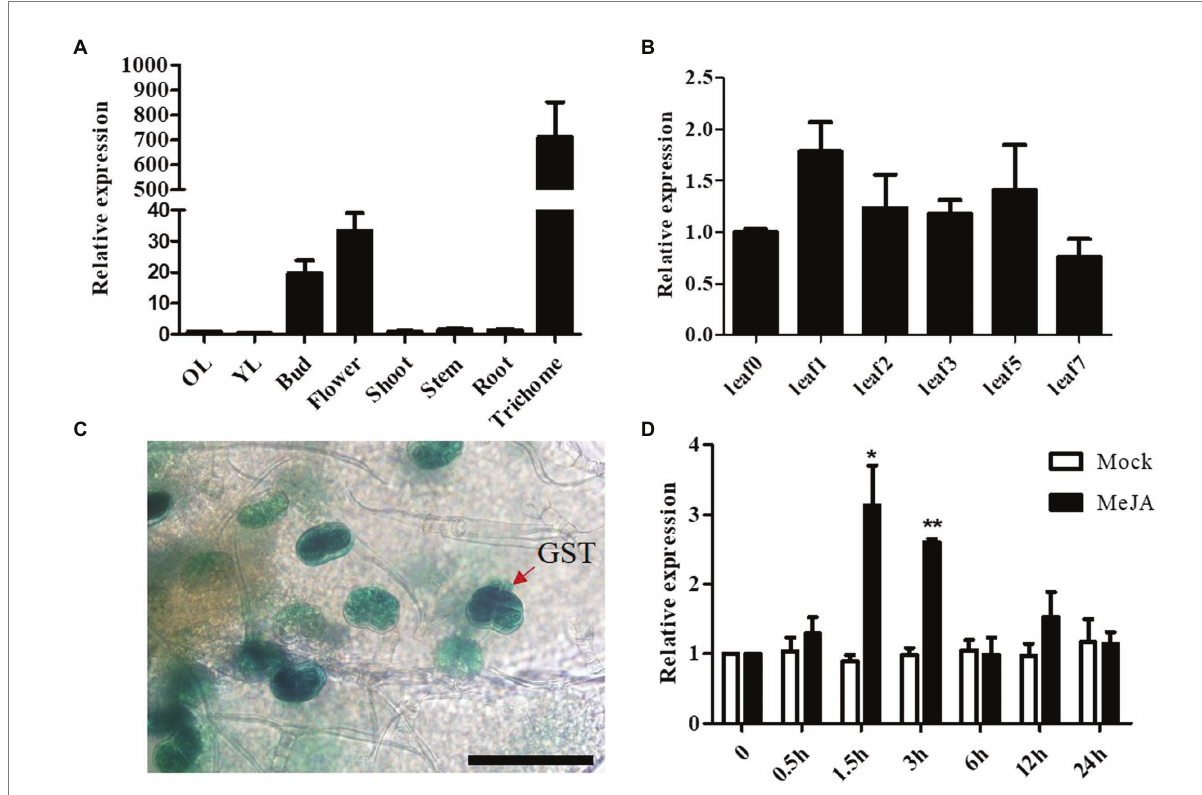
FIGURE 2 Transcript levels of AaSEP4 in Artemisia annua . (A, B) Relative expression levels of AaSEP4 in different tissues (A) and at different stages of leaves (B) . OL, old leaves; YL, young leaves. Data values are means ± SD ( n = 3). (C) β -Glucuronidase expression of 1391-pro AaSEP4 -GUS transgenic A. annua plants. Bars: 100 μ m. (D) Relative expression of AaSEP4 in response to methyl jasmonate (MeJA, 100 μ M) by RT-qPCR. Plants were treated with ddH 2 O as mock. All data are given as means ± SD ( n = 3) * p < 0.05; ** p < 0.01; Student’s t